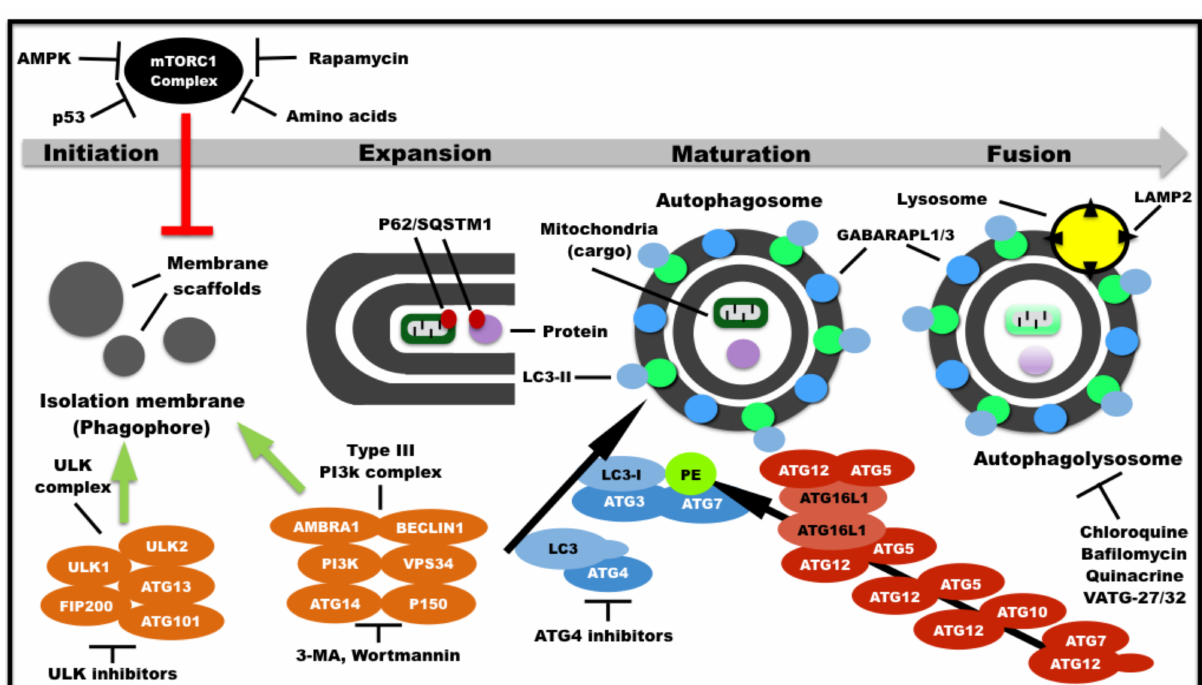
Figure 1. The mammalian autophagy pathway is a four-step process. Several environmental signals activate autophagy directly or indirectly, such as nutrient deprivation (e.g., amino acid depletion), DNA damage (p53-mediated transcription activation), developmental or environmental cues upstream of signaling pathways (e.g., adenosine monophosphate- activated protein kinase— AMPK ), and mammalian target of rapamycin complex 1 ( mTORC1 ) inhibitors (e.g., rapamycin). Autophagy initiation: cells exit homeostasis by inhibition the mTORC1 complex and induction of autophagy activating kinase 1/2 (ULK1/2) complex (formed by ULK1/2, autophagy-related protein 13— ATG13 , PTK2/FAK family interacting protein of 200 kDa— FIP200 , and Autophagy-related protein 101— ATG101 proteins) alongside type III phosphatidylinositol 3-kinase complex (formed by autophagy and beclin 1 regulator 1— AMBRA1, BECLIN1, PI3K , Vacuolar protein sorting 34— VPS34 , beclin 1-associated autophagy-related key regulator/autophagy-related protein 14—ATG14, mammalian homolog of yeast Vps15— P150 ). This activation forms an isolation membrane (phagophore) by sequestering part of a cellular membrane enclosing a fraction of the cytosol. The phagophore contains cargo such as organelles and/or macromolecules sequestered by adaptors such as sequestosome1 (p62/SQSTM1) . Expansion: the phagophore elongates and involves the cargo. The cysteine peptidase/autophagy-related protein (ATG4) , which is a component of the ubiquitin-like ATG8 (Light-chain 3 (LC3) ) system (blue), converts LC3 into LC3-I by proteolytic cleavage at the C-terminus. Further, both autophagy-related protein 3 (ATG3) and autophagy-related protein 7 (ATG7) conjugate LC3-I with the lipid phosphatidylethanolamine (PE). The LC3-I/PE aggregate anchored at the autophagosome membrane becomes LC3-II . Similarly, gamma-aminobutyric acid receptor-associated proteins (GABARAPLs) are subject to proteolytic cleavage at the C-terminus by ATG4 and conjugated to lipids by ATG3/ATG7 for phagophore membrane binding . LC3-II and GABARAPL conjugates contribute to membrane elongation, cargo recognition, autophagosome edge closure, autophagosomal movement, and tethering to lysosomes. The ubiquitin-like autophagy-related protein 12 (ATG12) system also contributes to ATG8 ( LC3 and GABARAPL ) conjugation. It initiates with an ATG12 cleavage by ATG7 in an ATP-dependent manner. Furthermore, ATG12 associates with autophagy- related protein 10 (ATG10) , thus forming another intermediate. Finally, ATG12 conjugates with autophagy-related protein 5 (ATG5) and the latter interacts with autophagy related 16 like 1 (ATG16L1). Furthermore, a dimeric ATG12-ATG5-ATG16L1 complex forms by ATG16L1 homodimerization. This dimer complex contributes to ATG8 -lipid conjugations. Maturation: The phagophore becomes a double-membrane enclosed vesicle named autophagosome. Fusion: the autophagosome fuses with a lysosome and becomes an autolysosome that allows complete degradation of cargo and release of cellular building blocks (e.g., amino acids and lipids) in the cytosol. The autolysosome formation requires the lysosome membrane-enriched glycoprotein lysosomal associated membrane protein 2 (LAMP2) . Stage-specific autophagy inhibitors were described. 3MA: